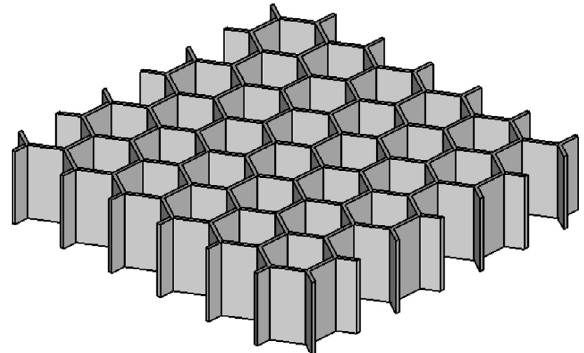
Figure 2. Hexagonal honeycomb resin configuration.